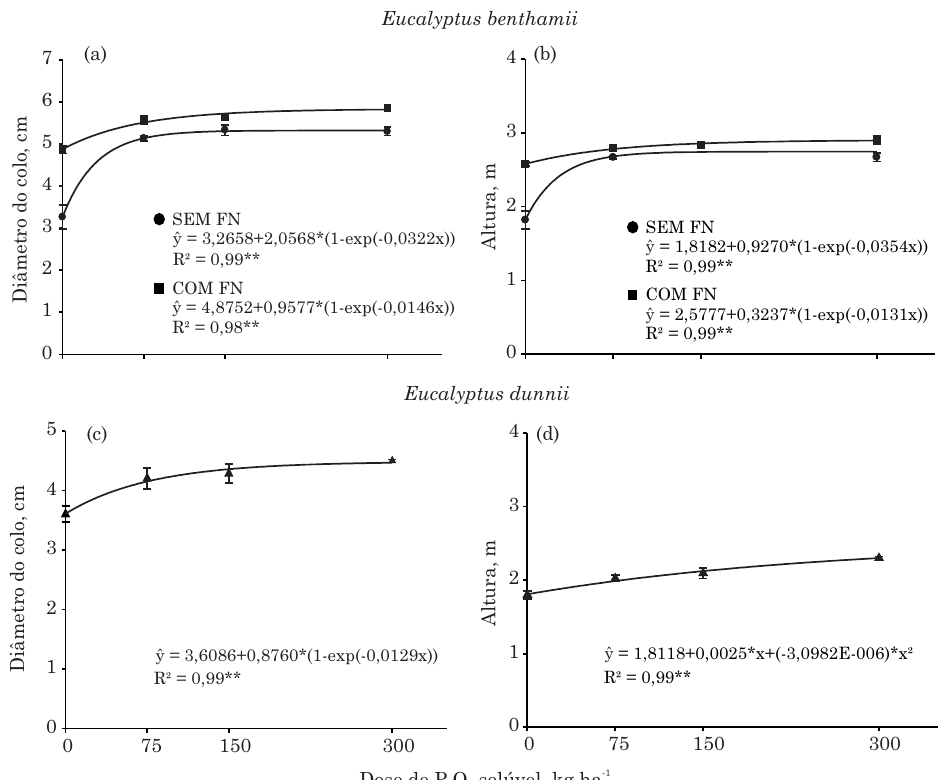
Figura 1. Diâmetro do caule à altura do colo e altura das plantas de Eucalyptus benthamii (a,b) e de Eucalyptus dunnii (c,d) submetidas às fontes e doses de P. ** significativo a 1 % pelo teste